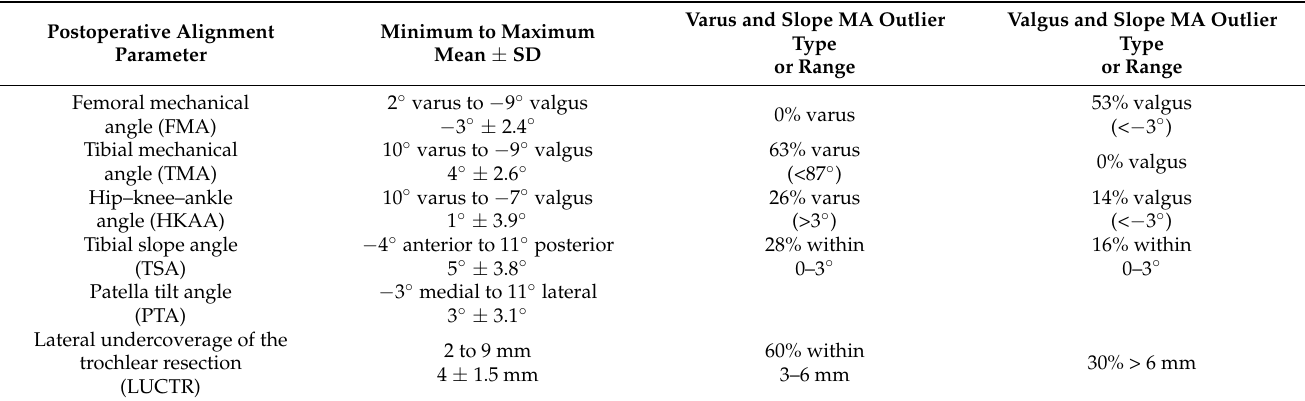
Table 3. The values, proportion, and type of outlier according to MA criteria for the six postoperative radiographic parameters.